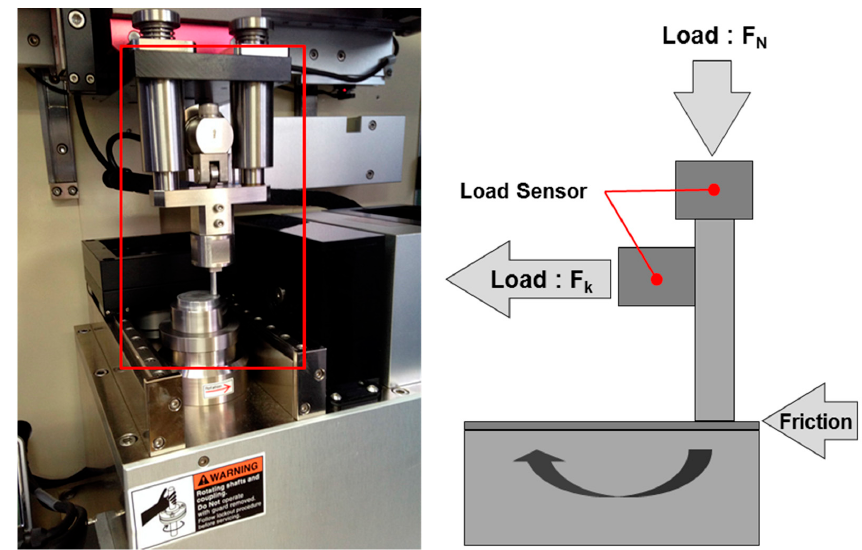
Figure 8. Friction test system and schematic image of the apparatus.